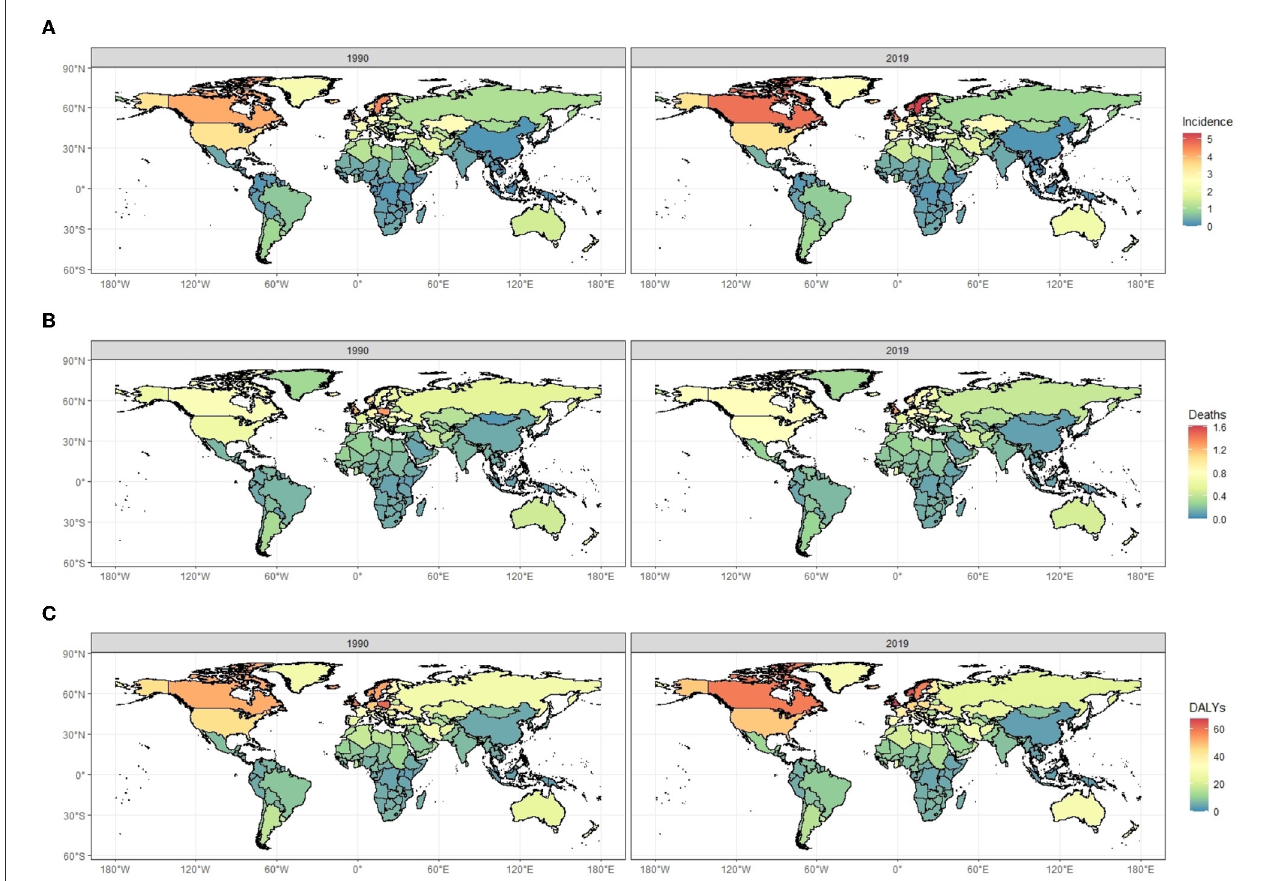
FIGURE3 The comparisons of age-standardized incidence rates (A) , death rates (B) , and DALYs rates (C) of multiple sclerosis (per 100,000 population) between 1990 and 2019 for both sexes, by location. DALYs, disability-adjusted life years.